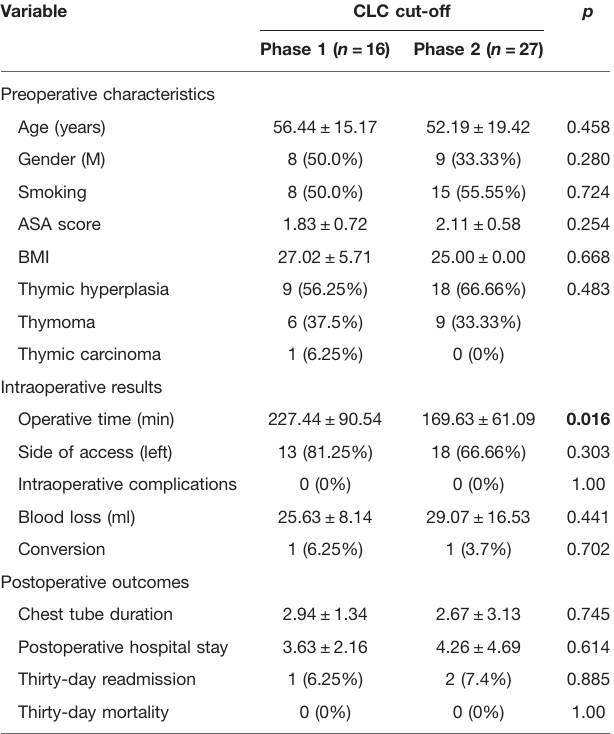
TABLE 3 | The clinicopathological characteristics and postoperative outcomes of non-MG patients strati fi ed by the completion of the learning curve (CLC)